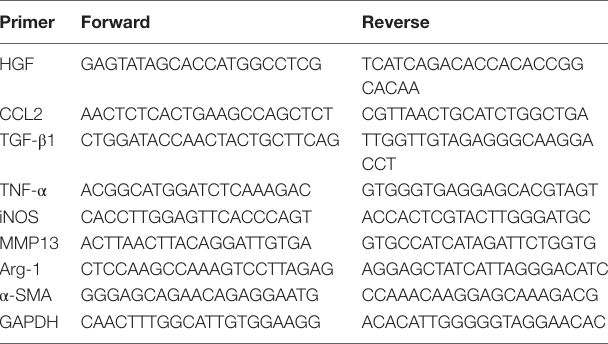
TaBle 1 | List of primers with respective sequences used for quantitative real- time